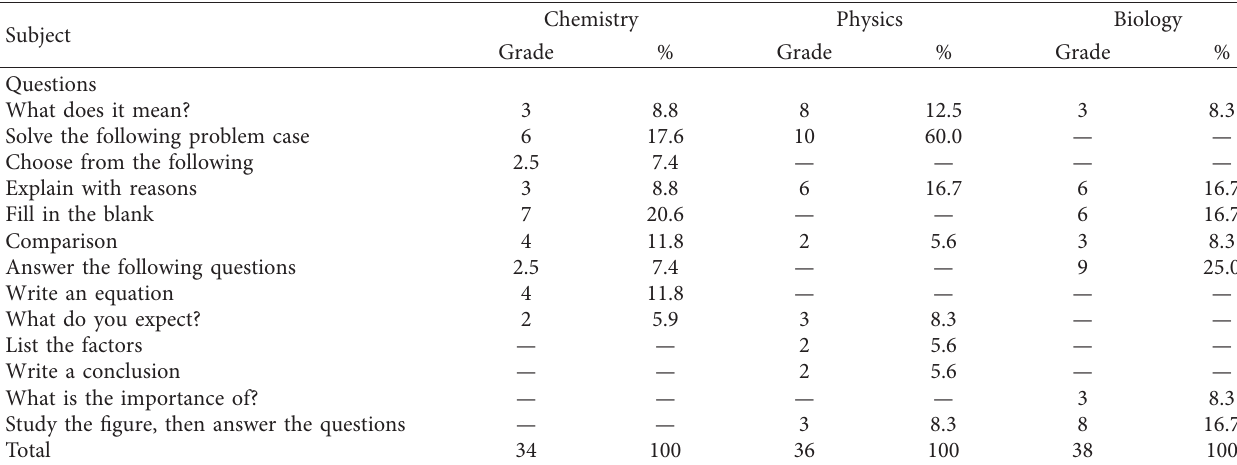
Table 11: Final examinations’ grading distribution of long answer questions for chemistry, physics, and